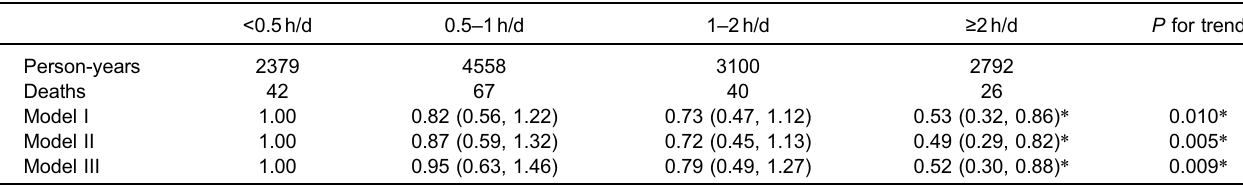
CI, con fi dence interval; h/d, hours/day; HR, hazard ratio. Values shown are HR (95% CI). * P <